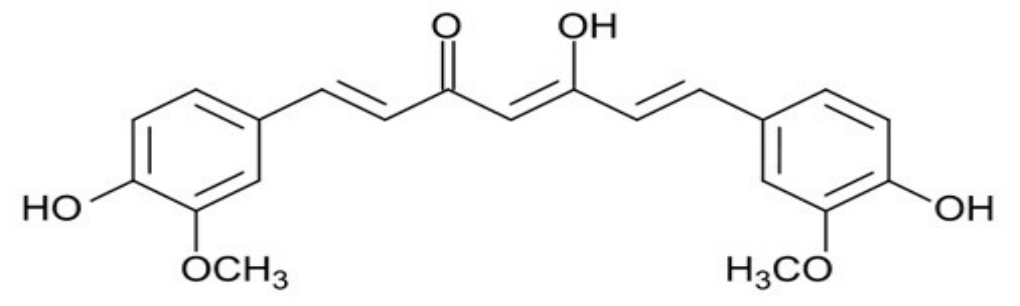
Figure 1. The chemical structure of